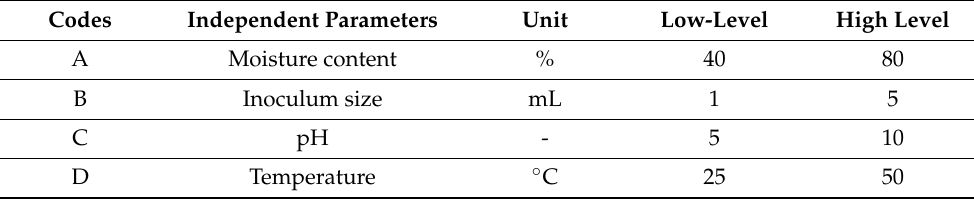
Table 1. Independent factors and their levels in a designed experiment.